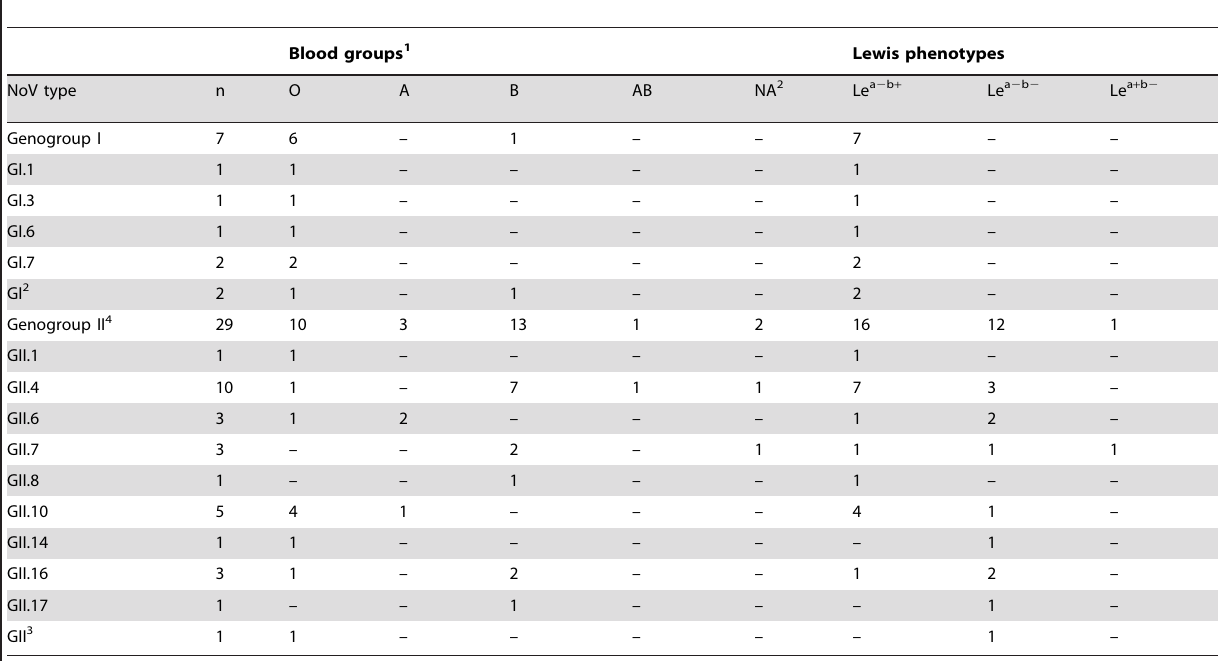
Table 5. Relationship between genogroups, genotypes, and HBGAs in NoV infected children in Burkina Faso.